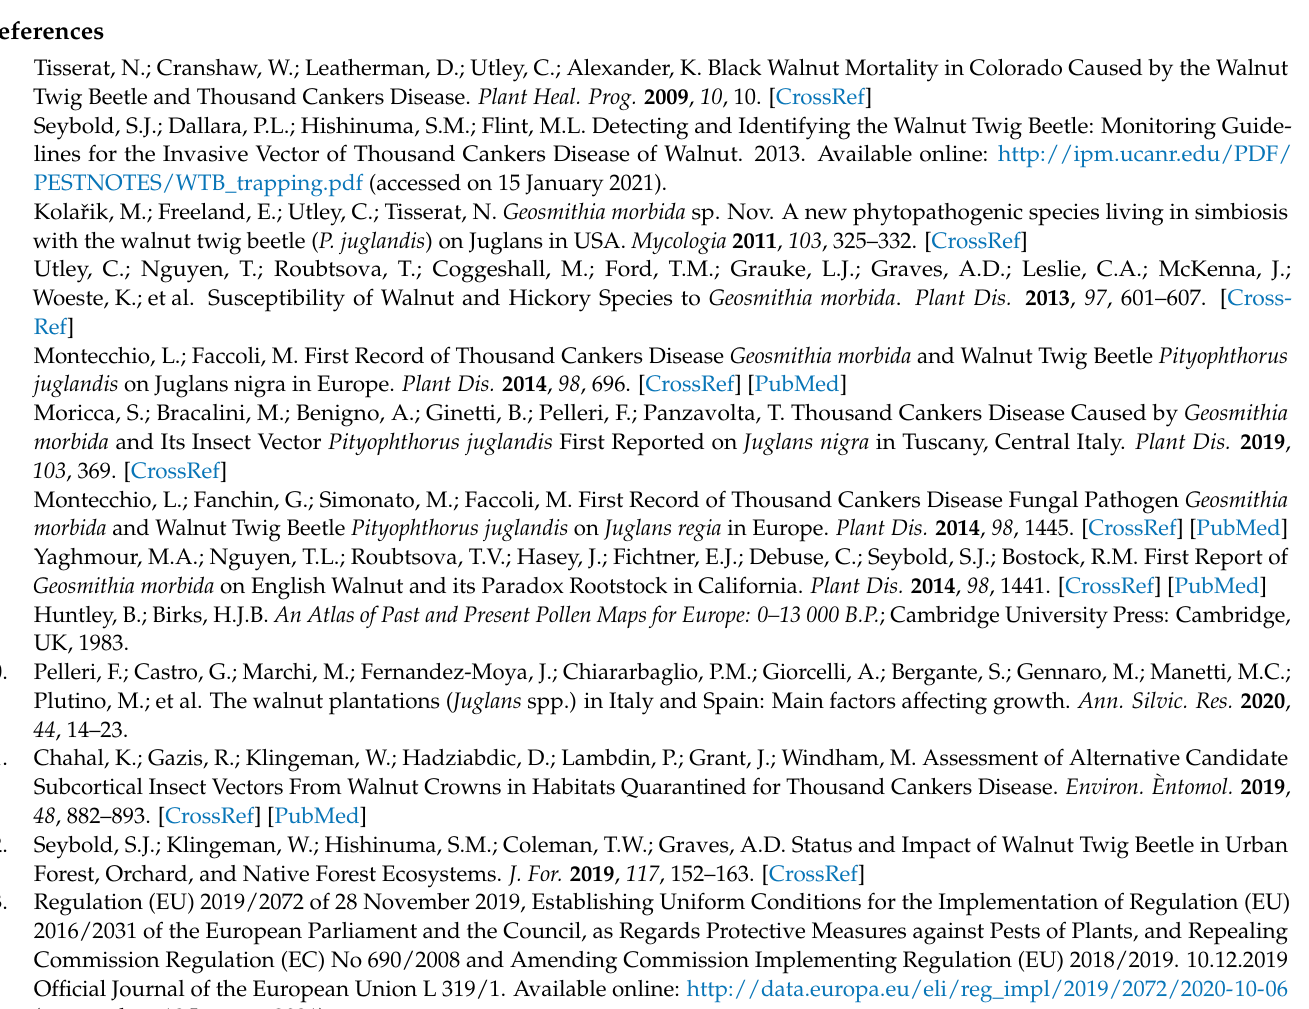
Table S2. Tamp means ± SD for the samples included in the blind